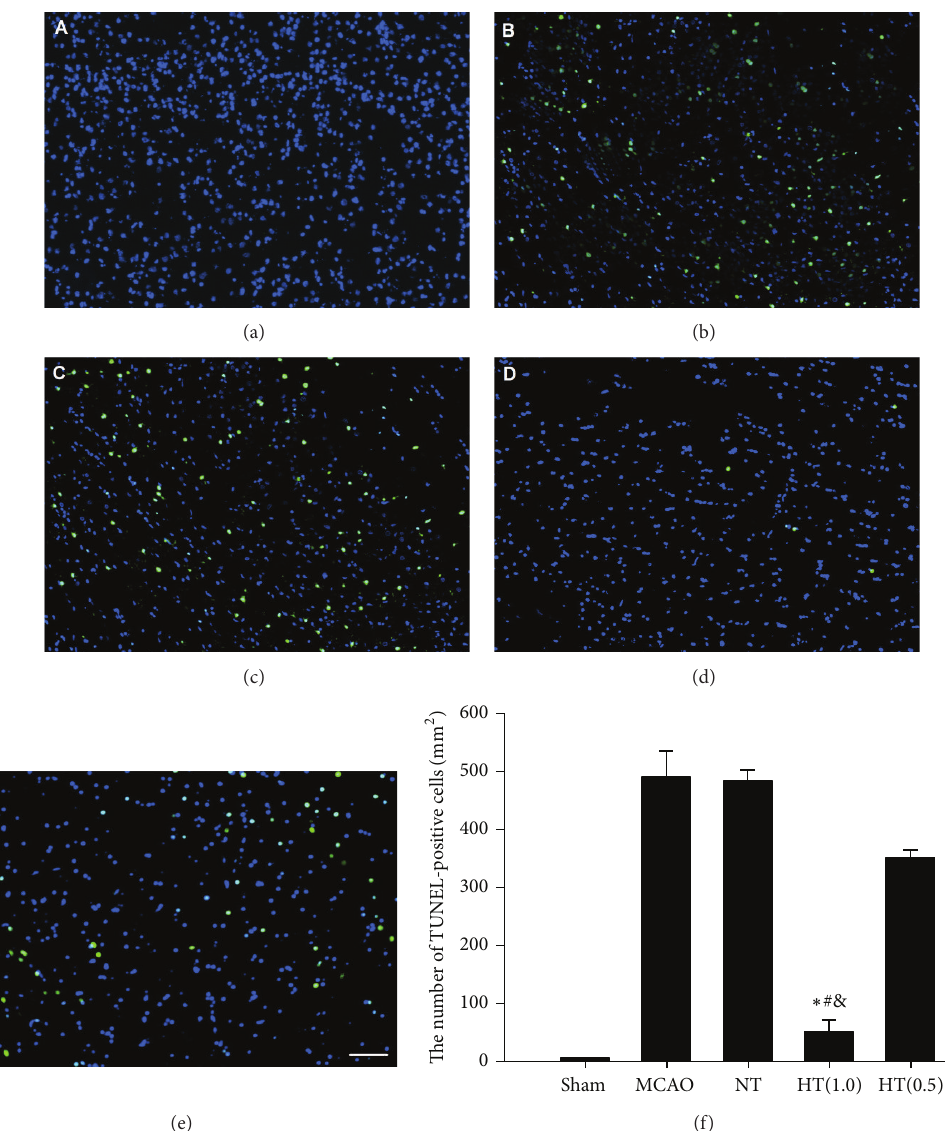
Figure 4: AIH inhibits neuronal apoptosis in the infarcted brain. (a–e) Fluorescence results of the TUNEL assay in the sham, MCAO, NT, HT(1.0), and HT(0.5) groups. Bright green dots were deemed apoptotic cells. Scale bar = 50 𝜇 m. (f) Quantitative analysis of apoptotic cells 24 h after ischemia. TUNEL-positive cells were counted from 3 random 1 × 1mm 2 areas. All values are the mean ± SEM. ∗ 𝑃 < 0.05